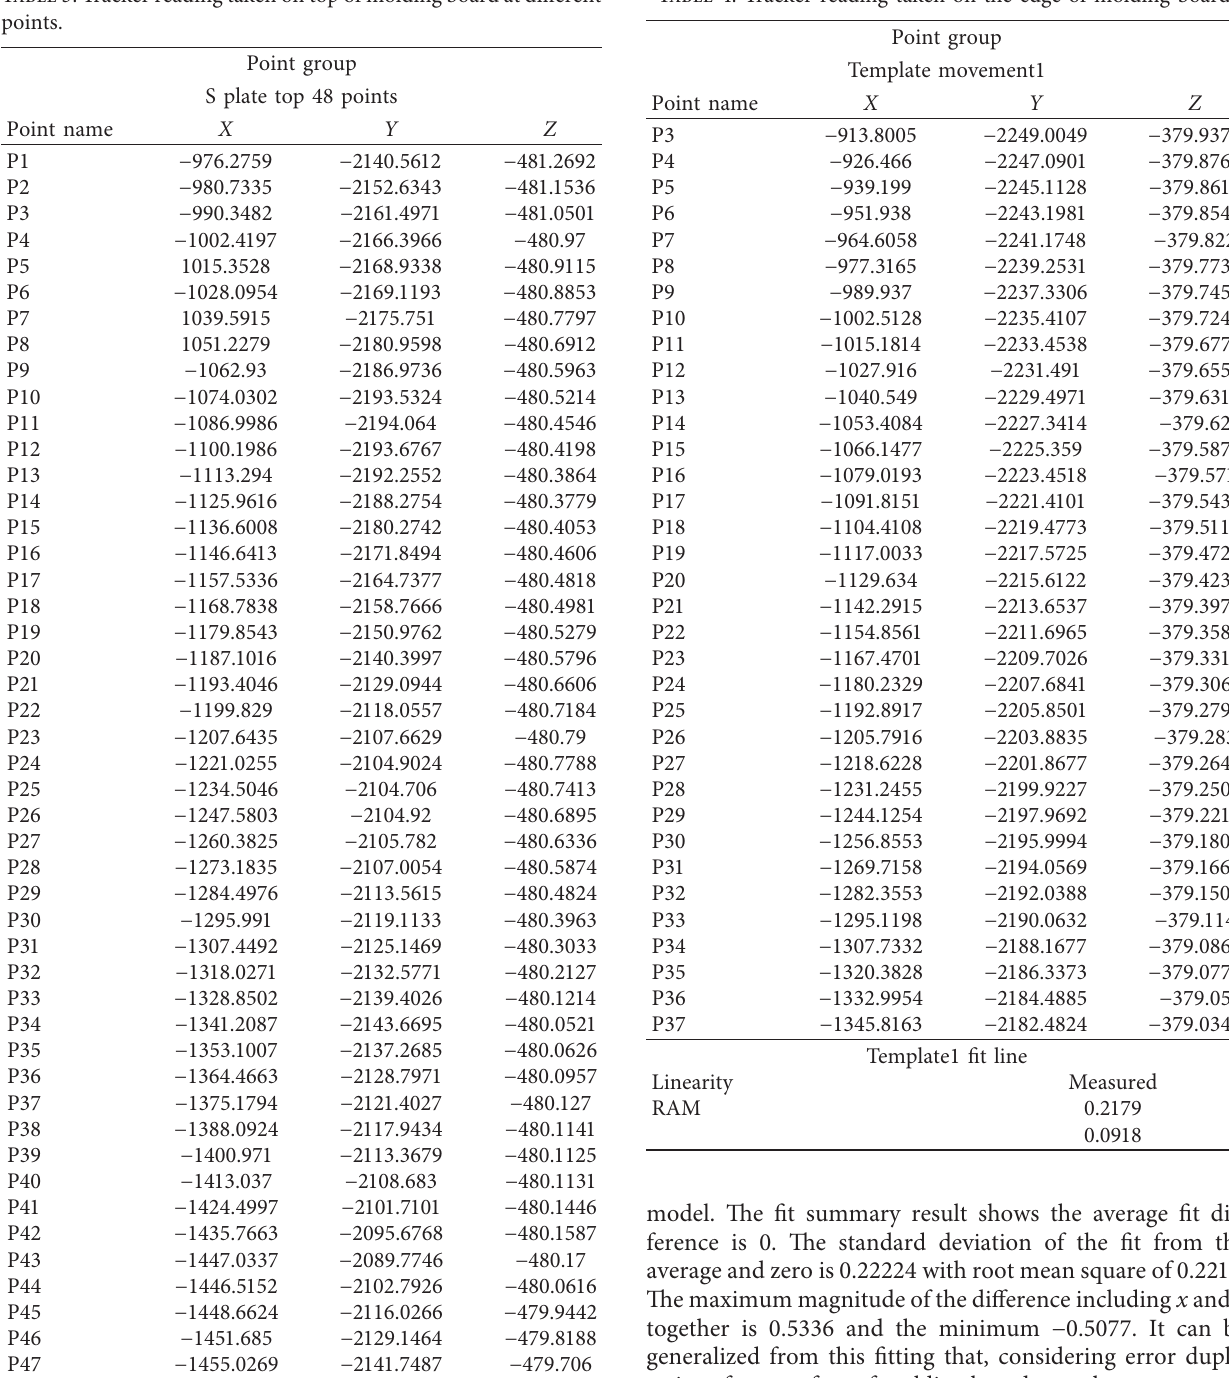
Table 4: Tracker reading taken on the edge of molding